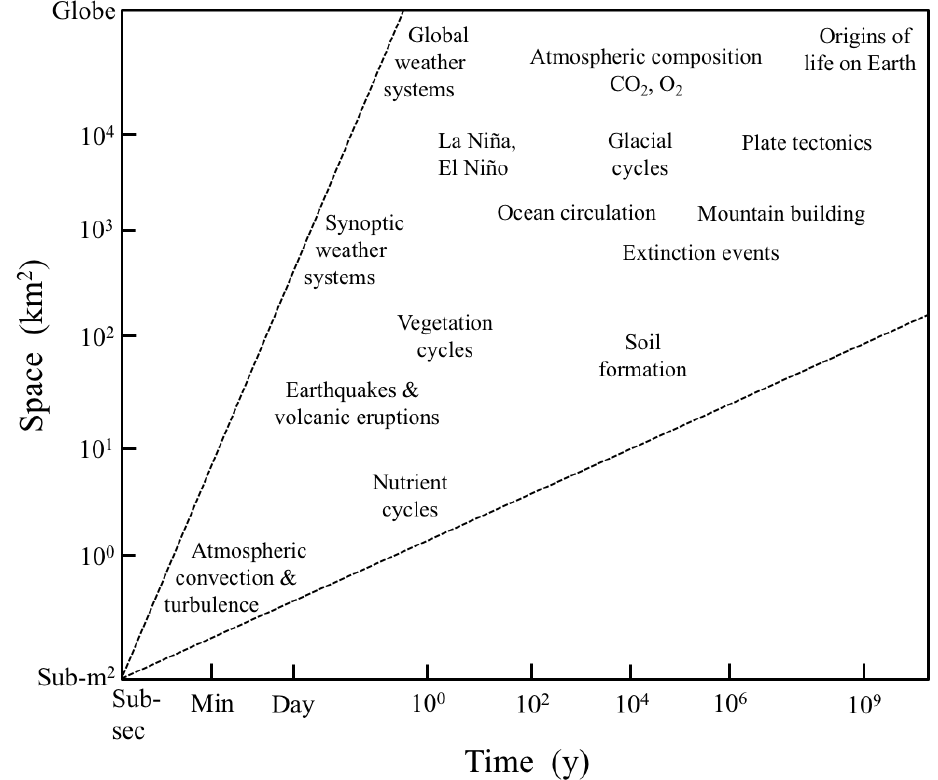
Figure 6. A space–time diagram of the sort used to justify LTER’s emphasis on extending ecosystem research into longer timescales and larger spatial scales (modified from Wu, 1999). Spatial–temporal scales of interest in ecology and Earth sciences overlap from small to large and from instantaneous to many millions of